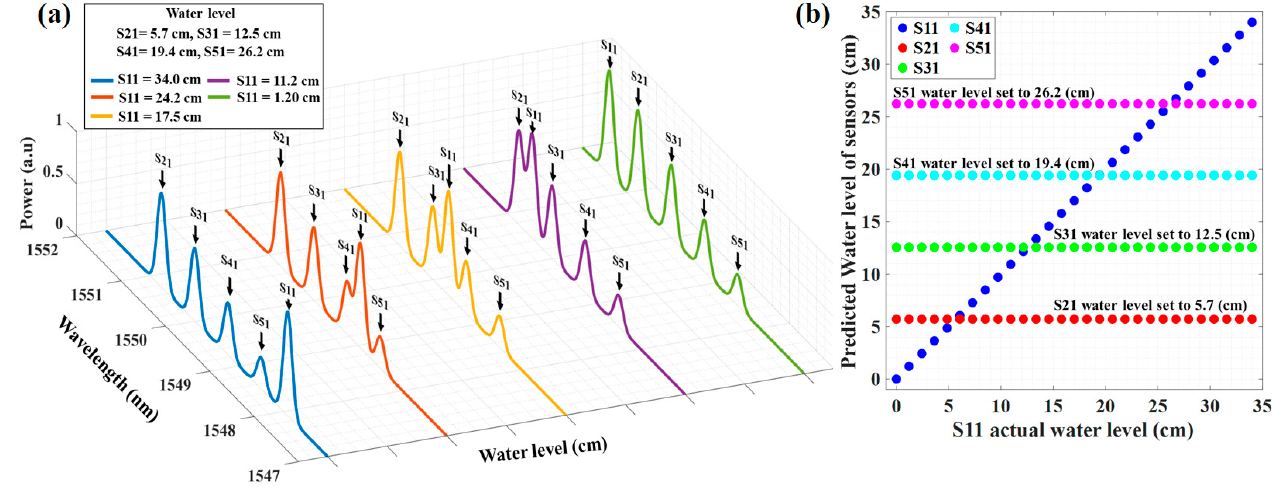
Figure 9. ( a ) The simulation results of reflected spectra of five water level sensors in five different water level steps, and ( b ) the predicted water level versus the actual water level of five sensors.